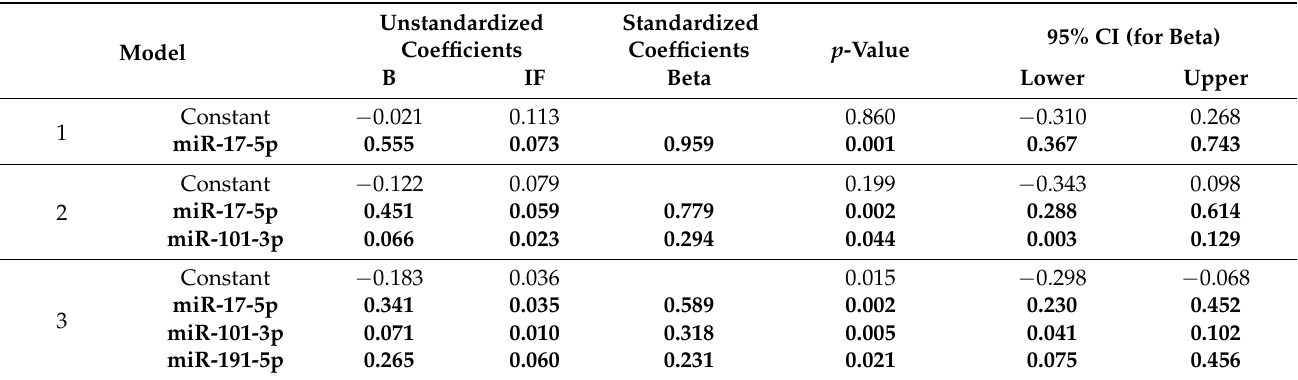
Table 3. Multivariate analyses (linear regression) identifying microRNAs of risk of death due to tumor progression in patients with metastatic papillary thyroid carcinoma.